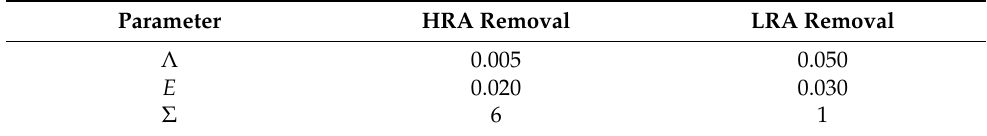
Table A1. Relative total variation (RTV) texture extraction settings used within HRA and LRA removal algorithms.